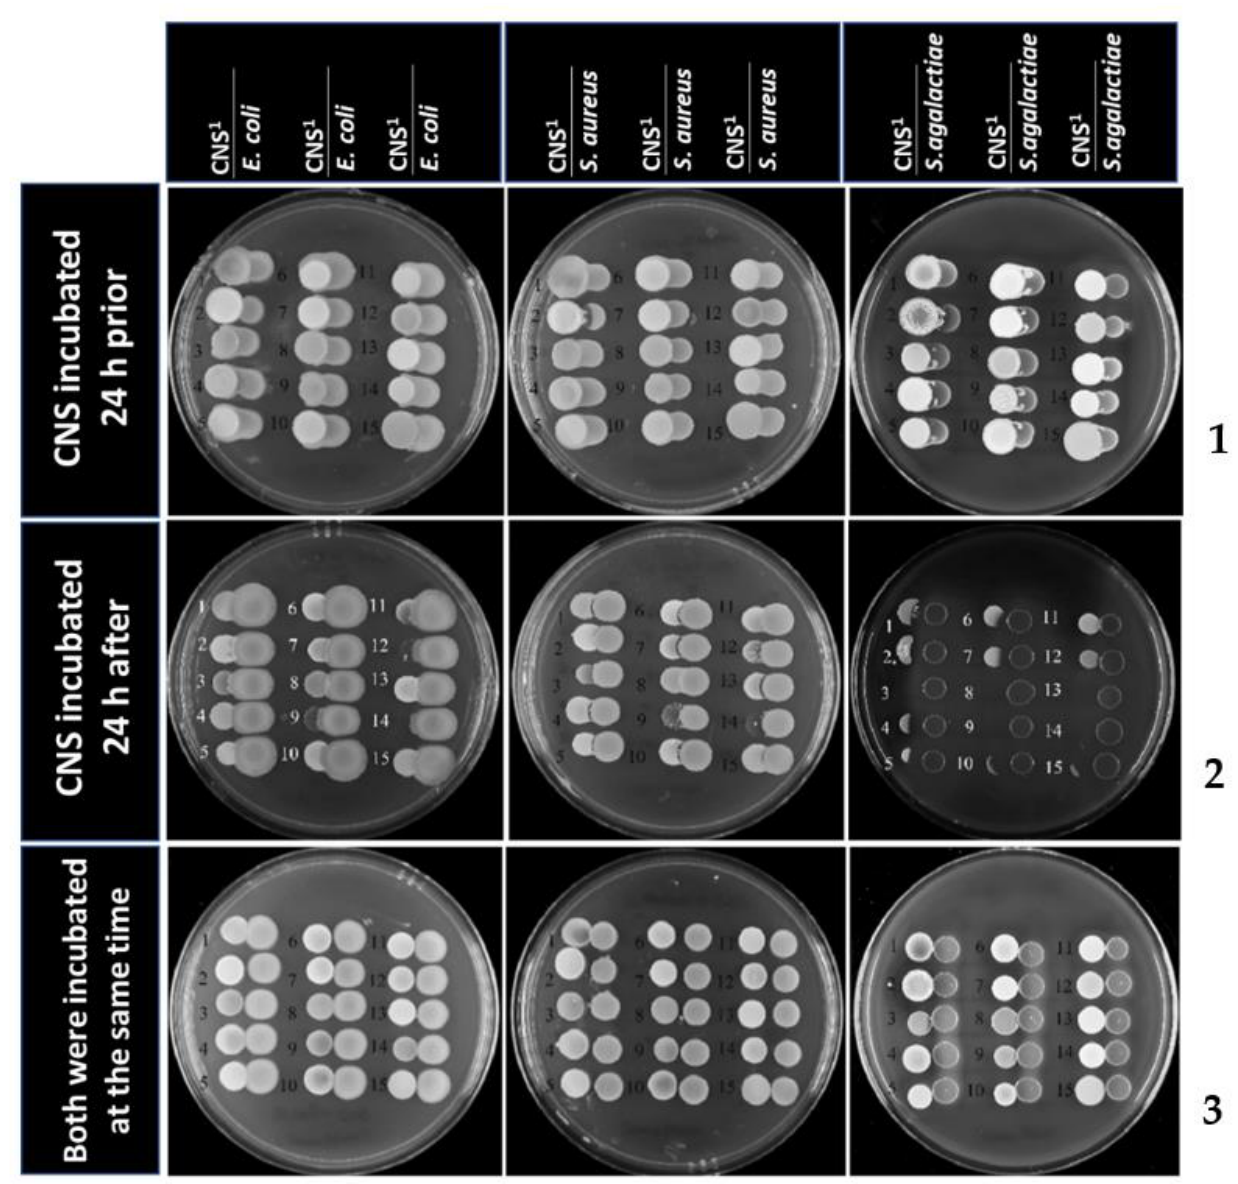
Figure 1. The inhibition zone of major strains toward minor strains in PRIOR condition. ( 1 ) 24-h prior incubation with CNS (upper), AFTER condition; ( 2 ) twenty-four-hour prior incubation with major pathogens (middle), EQUAL condition; ( 3 ) starting incubation at the same time (lower). 1 Coagulase-negative pathogens included 1., 2. S. chromogenes ; 3., 4. S. epidermidis ; 5., 6. S. haemolyticus ; 7. S. simulans ; 8., 9. S. warneri ; 10. S. xylosus ; 11. S. epidermidis ; 12. S. hominis ; 13. S. cohinii ; 14. S. capitis ; 15. S. sciuri .